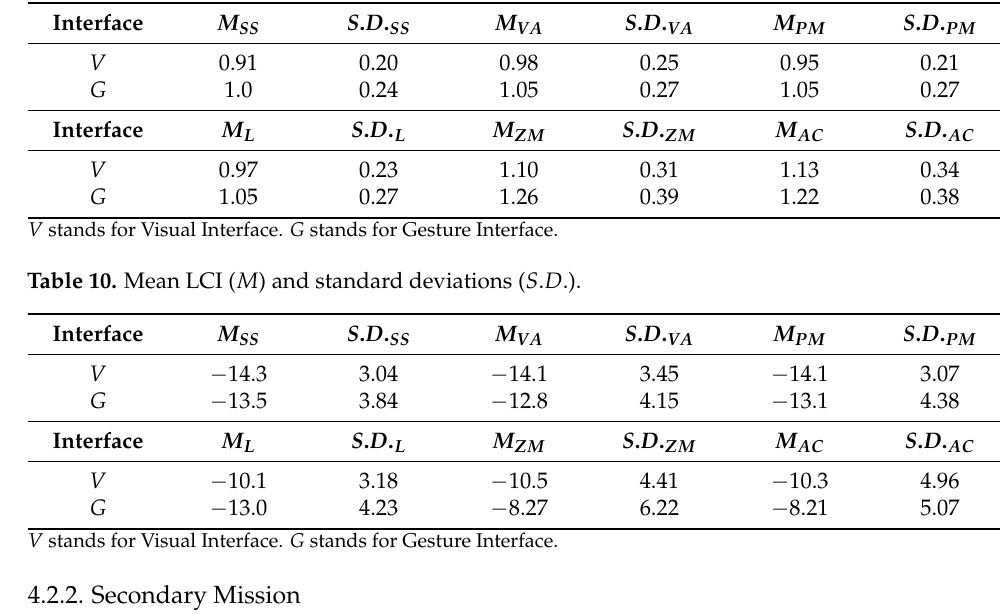
Table 9. Mean MDEV ( M ) and standard deviations ( S . D .).